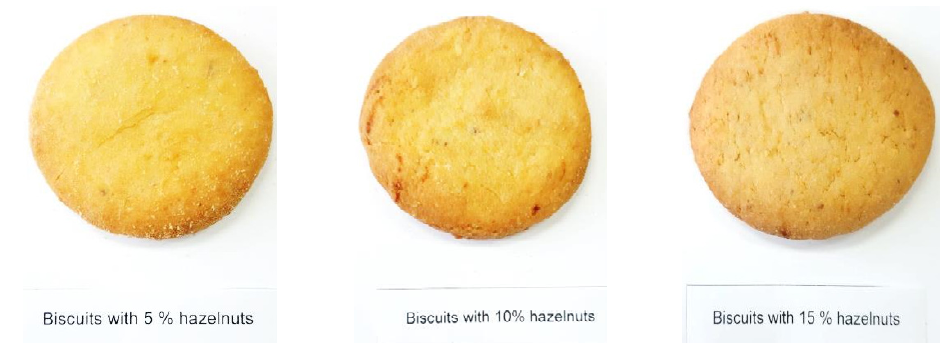
Figure 3. Images of prepared hazelnut biscuits.